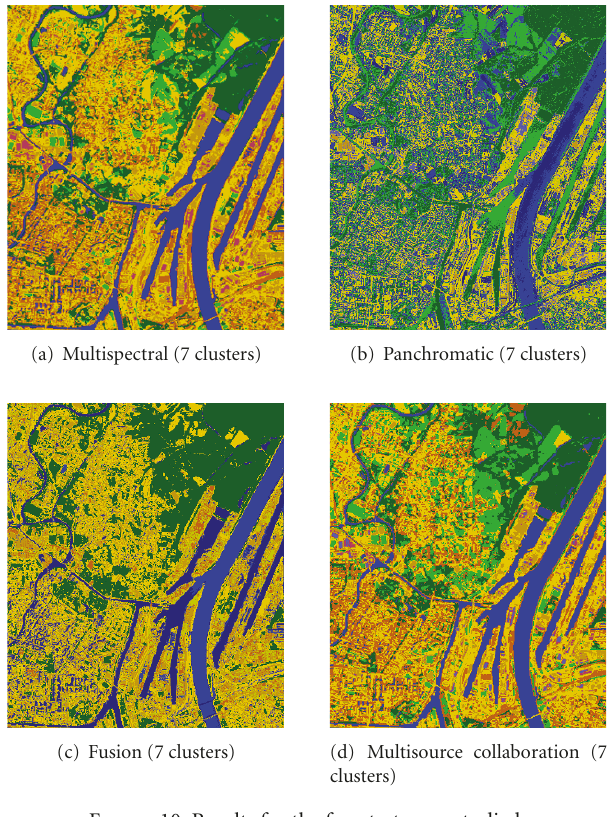
Figure 10: Results for the four test cases